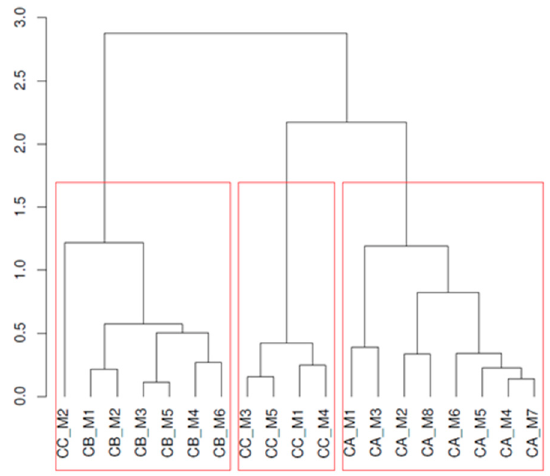
Figure 4. Dendrogram Ward clustering on MDS distances (3-cluster solution).